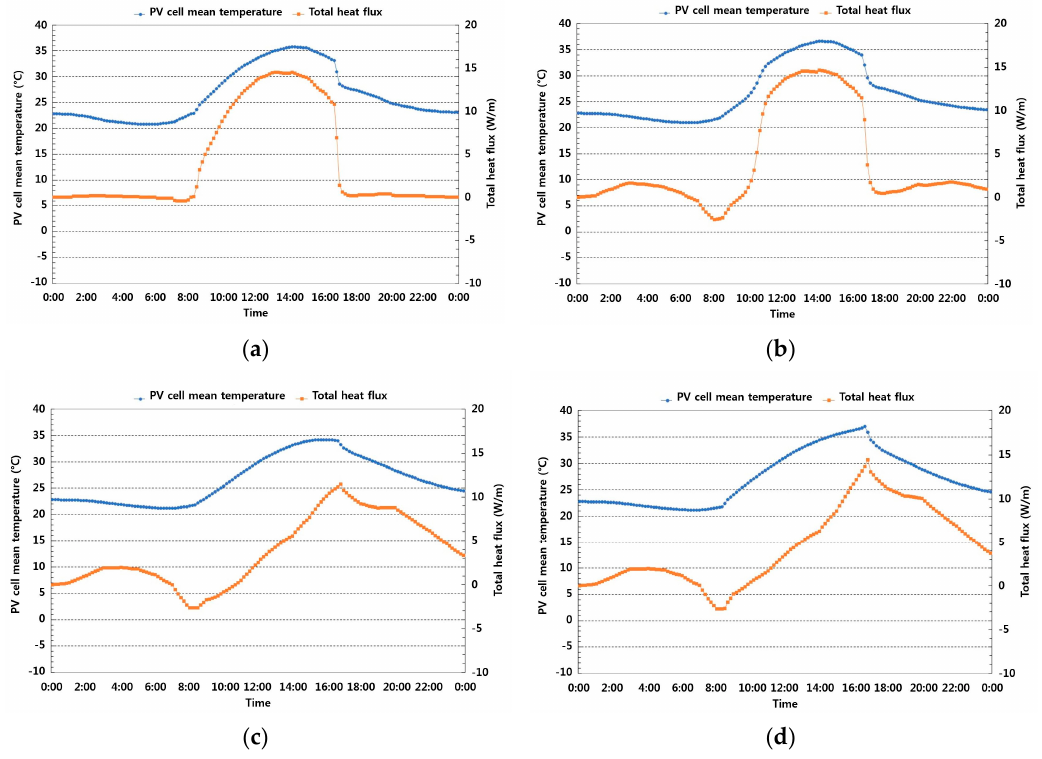
Figure 7. Comparison of mean operating temperatures of PV cell and total heat flux from panel to surrounding under the clear sky and hot temperature (summer season): ( a ) Case1; ( b ) Case2 PCM1; ( c ) Case2 PCM2; and ( d ) Case3 PCM2.